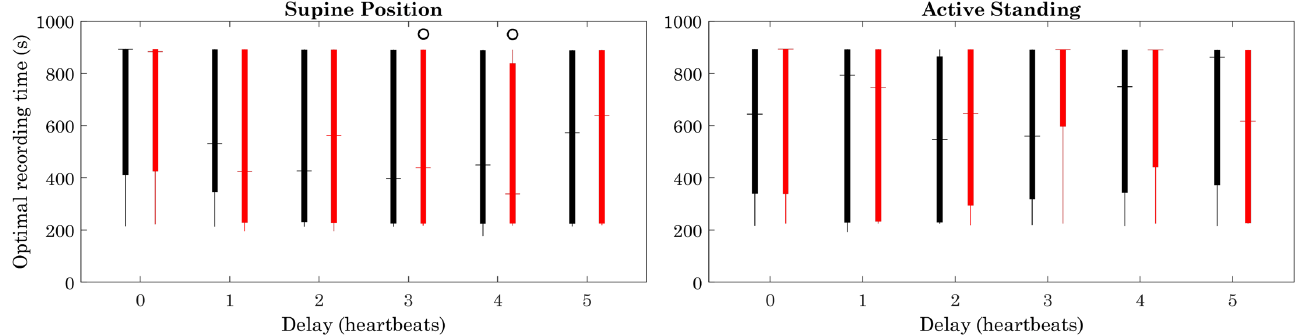
Figure 8. Optimal recording time. Figure symbology: Healthy subjects (black), ESRD patients (gray). Open circle: Supine Position vs. Active Standing (within same group), p < 0.05.